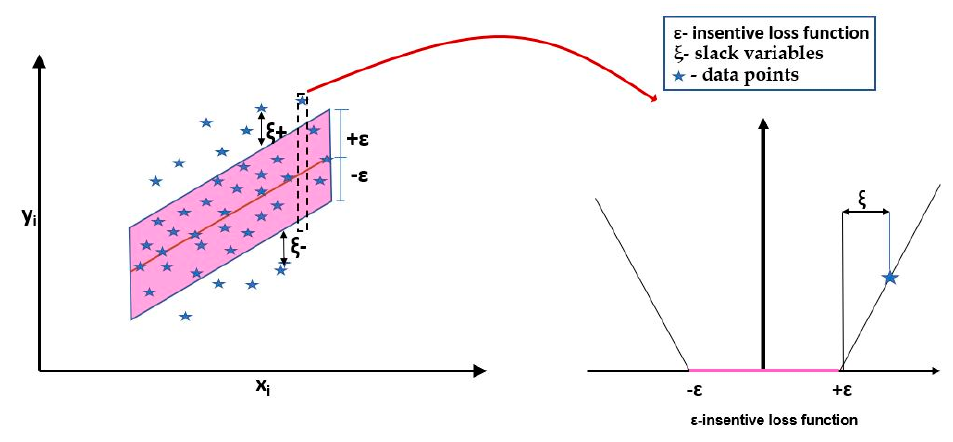
Figure 5. SVM Figure 5. SVM Layout.